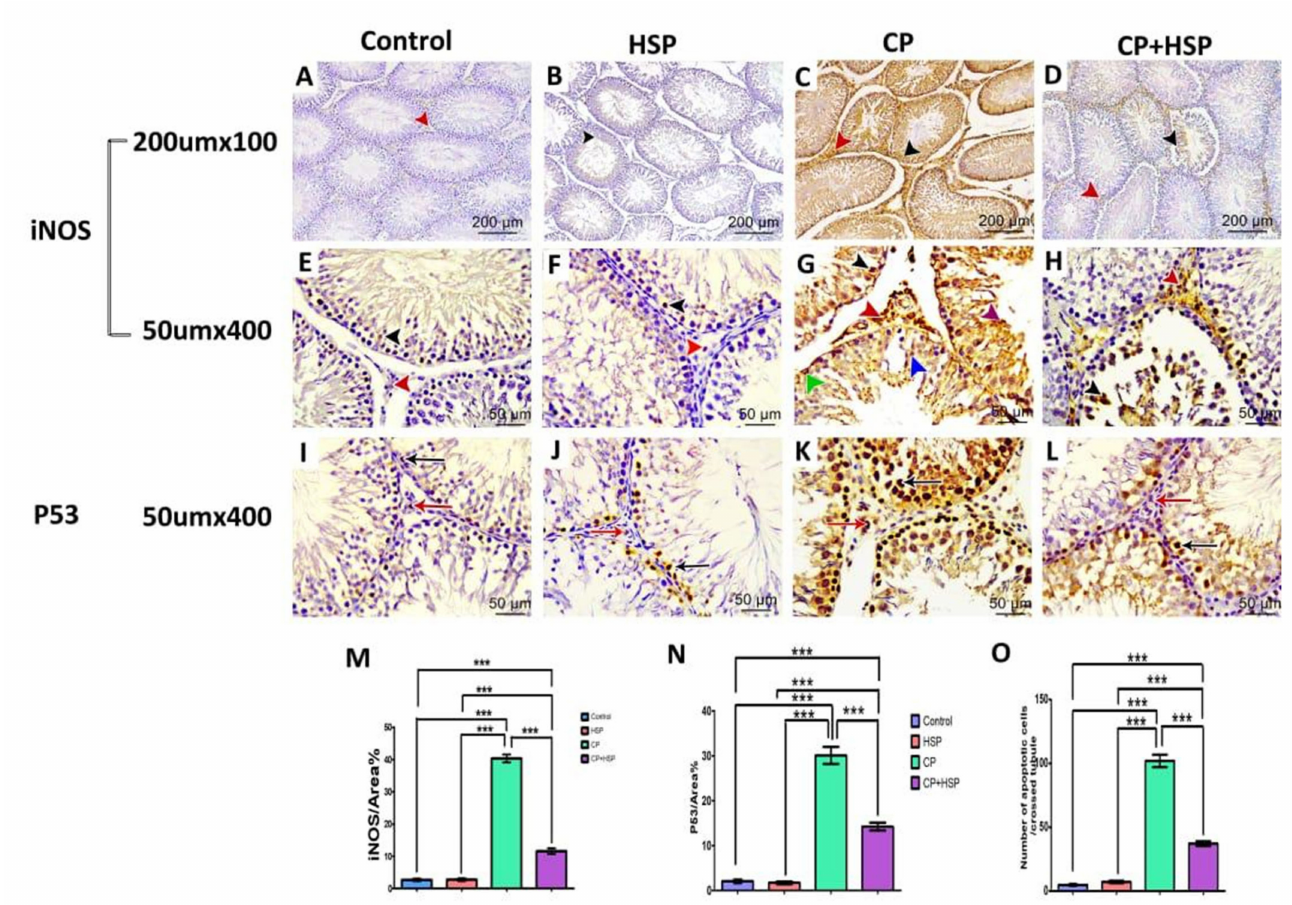
Figure 4. Effect of hesperidin administration in cyclophosphamide-induced testicular impairment in male rats on testicular immunohistochemical staining of iNOs and P53, as indicated by a positive im- mune reaction (arrowheads and arrows) in the cytoplasm and nuclei of the Leydig cells and germ cells of different studied groups ( A – O ). ( A ) Testicular immunohistochemical stained sections of iNOs in control-treated groups. Scale bar = 200 µ m, X100. ( B ) Testicular immunohistochemical stained sections of iNOs in HSP-treated group. Scale bar = 200 µ m, X100. ( C ) Testicular immunohistochemical stained sections of iNOs in CP-treated group. Scale bar = 200 µ m, X100. ( D ) Testicular immunohistochemical stained sections of iNOs in CP+HSP-treated group. Scale bar = 200 µ m, X100. ( E ) Testicular immuno- histochemical stained sections of iNOs in control-treated groups. Scale bar = 50 µ m, X400. ( F ) Testic- ular immunohistochemical stained sections of iNOs in HSP-treated group. Scale bar = 50 µ m, X400. ( G ) Testicular immunohistochemical stained sections of iNOs in CP-treated group. Scale bar = 50 µ m, X400. ( H ) Testicular immunohistochemical stained sections of iNOs in CP+HSP-treated group. Scale bar = 50 µ m, X400. ( I ) Testicular immunohistochemical stained sections of P53 in control-treated groups. Scale bar = 50 µ m, X400. ( J ) Testicular immunohistochemical stained sections of P53 in HSP-treated group. Scale bar = 50 µ m, X400. ( K ) Testicular immunohistochemical stained sections of P53 in CP-treated group. Scale bar = 50 µ m, X400. ( L ) Testicular immunohistochemical stained sections of P53 in CP+HSP-treated group. Scale bar = 50 µ m, X400. ( M ) Immunostaining intensity of testicular iNOs (% area). ( N ) Immunostaining intensity of testicular P53 (% area). ( O ) Number of apoptotic cells per crossed tubule. Data are expressed as means ± SEM. *** indicate significant difference ( p <